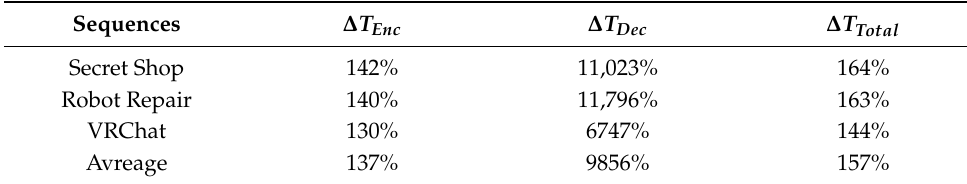
Table 2. Encoding and decoding